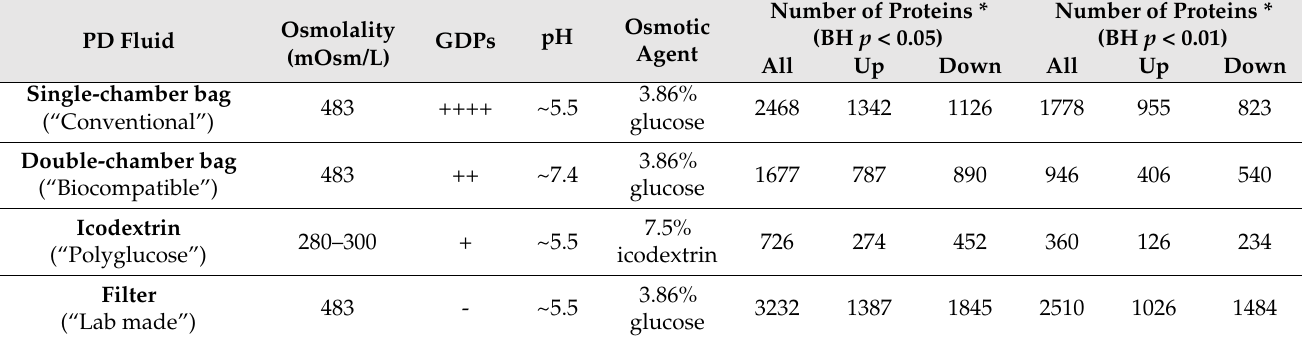
Table 1. PD fluids properties and proteins significantly regulated following exposure versus con- trol conditions.